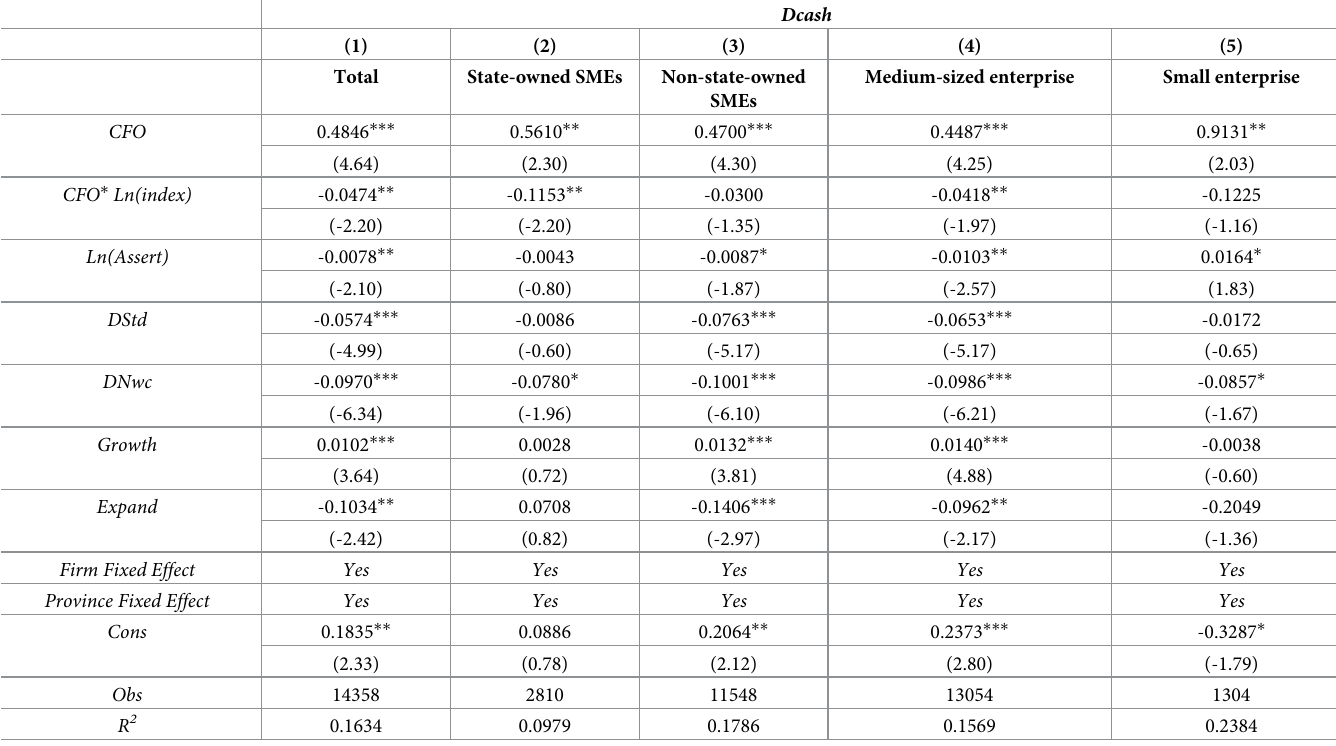
Table 7. Empirical results of the financing capacity